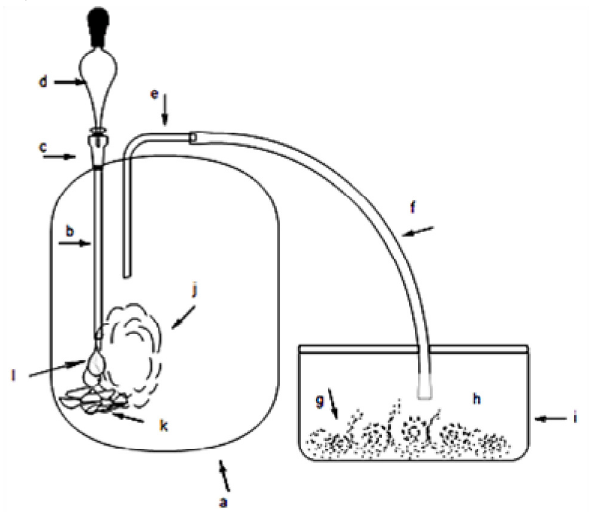
Fig. 1. Schematic picture of the programmed system for producing acetylene solution; Reaction chamber (a); Water pipe (b) which leads to reaction chamber; Stopcock (c); Water dropper (d); Gas pipe (e) which leads to the water chamber; Gas transfer hose (f); Seeds (g); Water (h); Water chamber (i); Acetylene gas (j); Calcium carbide particles (k); Drops of water